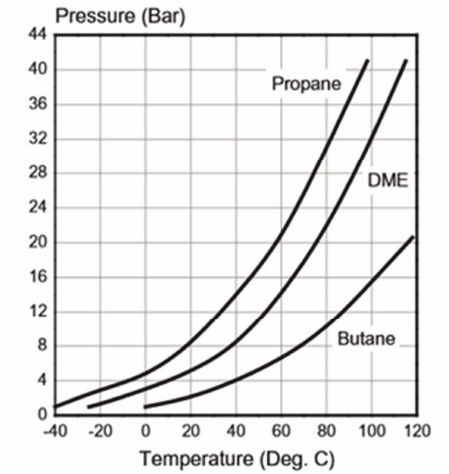
Fig. 2. Comparison of the vapor pressure of dimethyl ether and propane and butane [4]